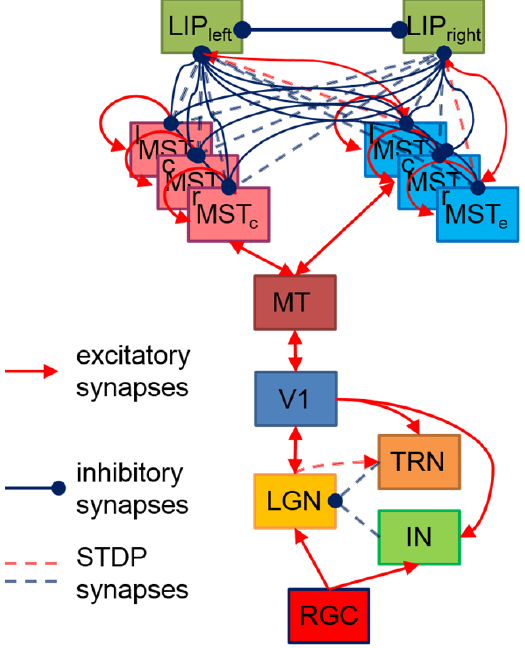
Fig. 1. Model structure as in [11].